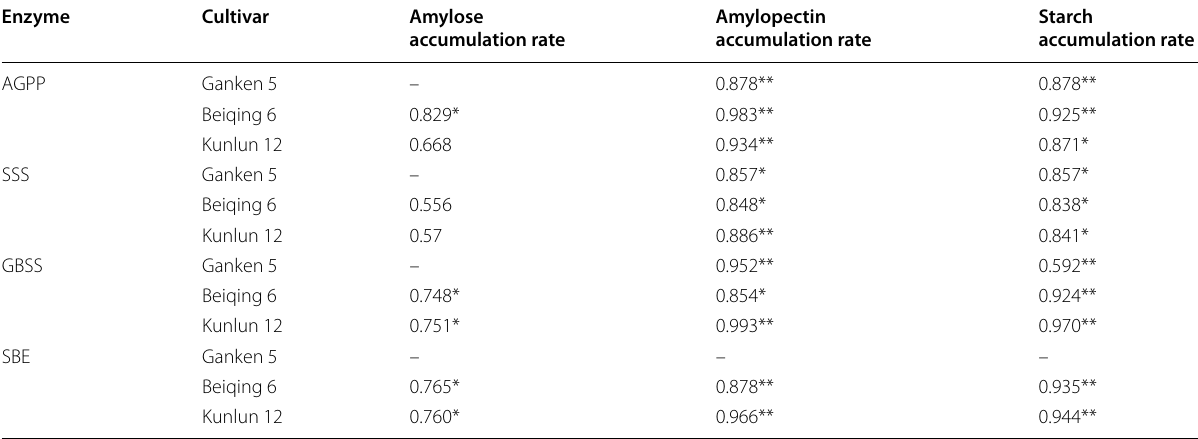
Table 3 Correlation analysis between enzyme activity and starch accumulation rate in three hulless barley cultivars at grain